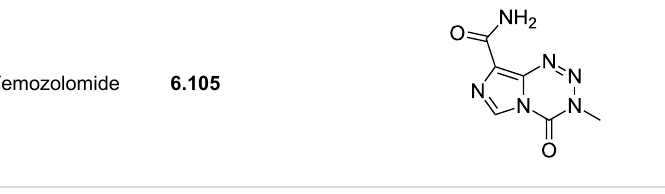
Table 1: Chemical structures of the heterocyclic compounds discussed in this review. (continued)